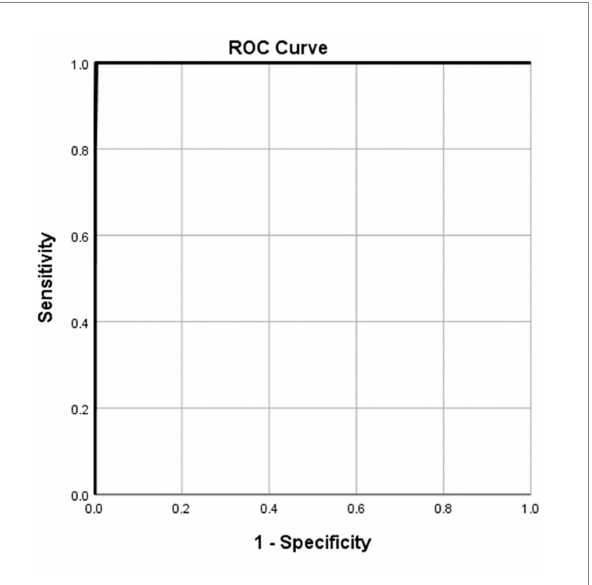
FIGURE 4 Using characteristics of NRS2002 score on admission for discriminating the surviving cases from the dead patients ( n = 1,228; surviving and dead groups, n = 1223 and 5, respectively). ROC analysis showing the performance of NRS2002 score in distinguishing the dead cases from the surviving patients. The parametric estimate of the area under the ROC curve and its 95% confidence interval are 0.999 and 0.998 ~ 1.000, respectively. ROC, receiver operating characteristic curve; AUC, area under the